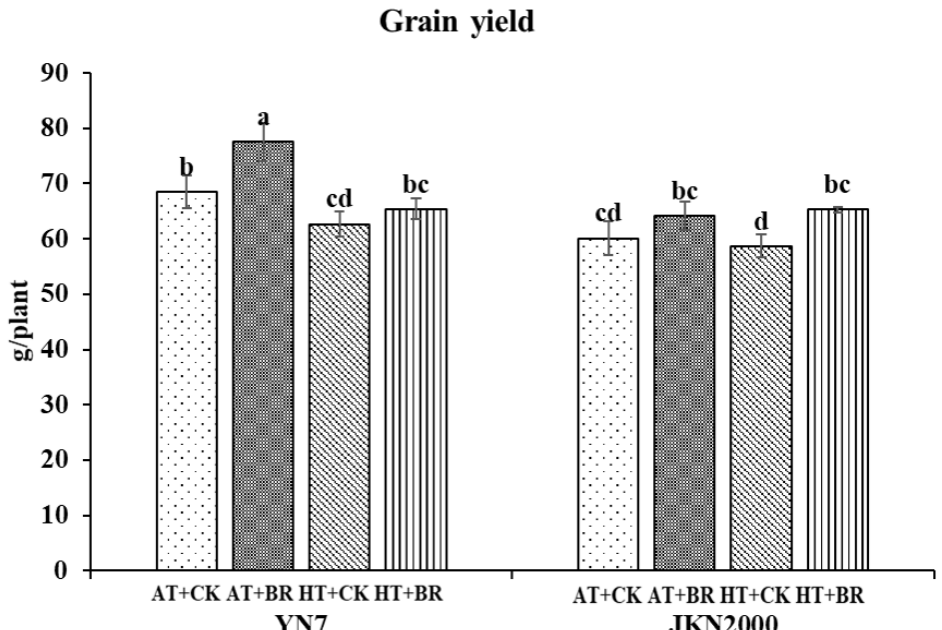
Figure 1. Effects of exogenous BR application at the silking stage on the grain yield of waxy maize under post–silking ambient and high temperatures. YN7, Yunuo7; JKN2000, Jingkenuo2000; AT, ambient temperature; HT, high temperature; CK, control, plants sprayed with 100 mL water; BR, brassinolide, plants sprayed with 100 mL 0.25 mg/L BR. Within columns, those followed by the same letters are not significantly different ( p < 0.05).